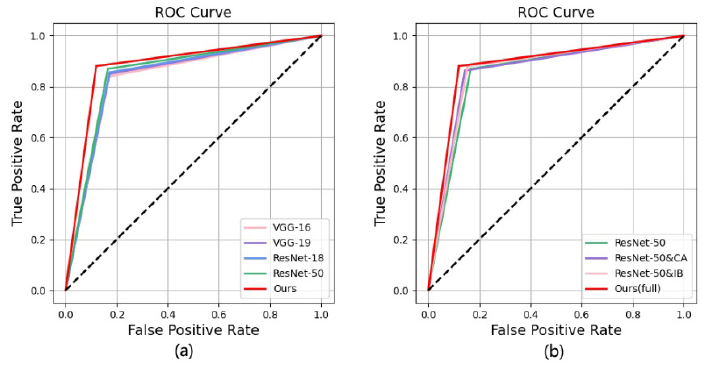
Figure 7 . Comparison of ROC curves of different methods. The solid red line represents our method. ( a , b ) show the results of our methods in qualitative and quantitative experiments, respectively.